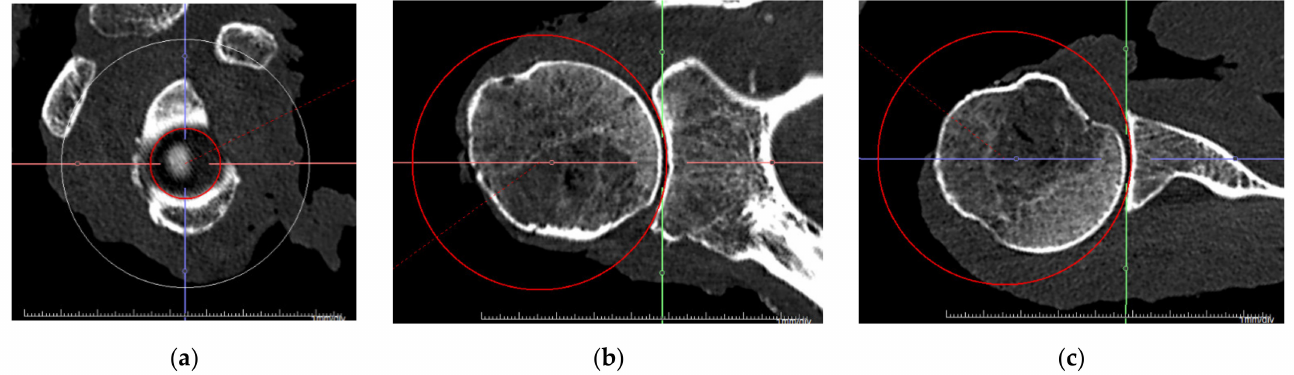
Figure 3. Alignment of a best-fit sphere. The three-dimensional sphere was adjusted to the glenoid surface in a best-fit approach for all three view planes: ( a ) sagittal view; ( b ) coronal view; ( c ) transversal